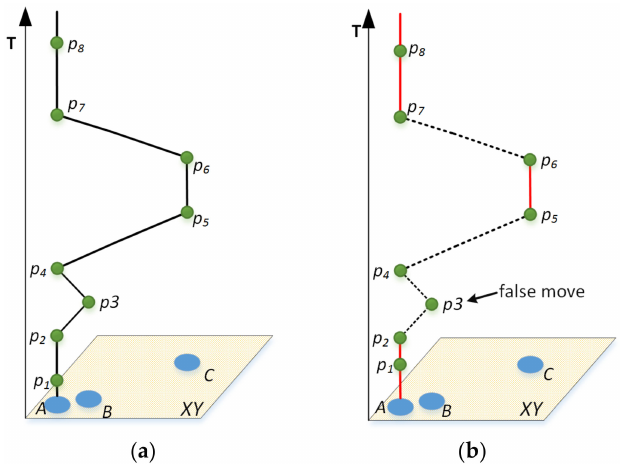
Figure 6. Human activity detection from mobile phone records. ( a ) The trajectory of a mobile phone user; ( b ) trajectory segmentation. Vertical segments denote human activities at fixed places. Slope segments denote moves between